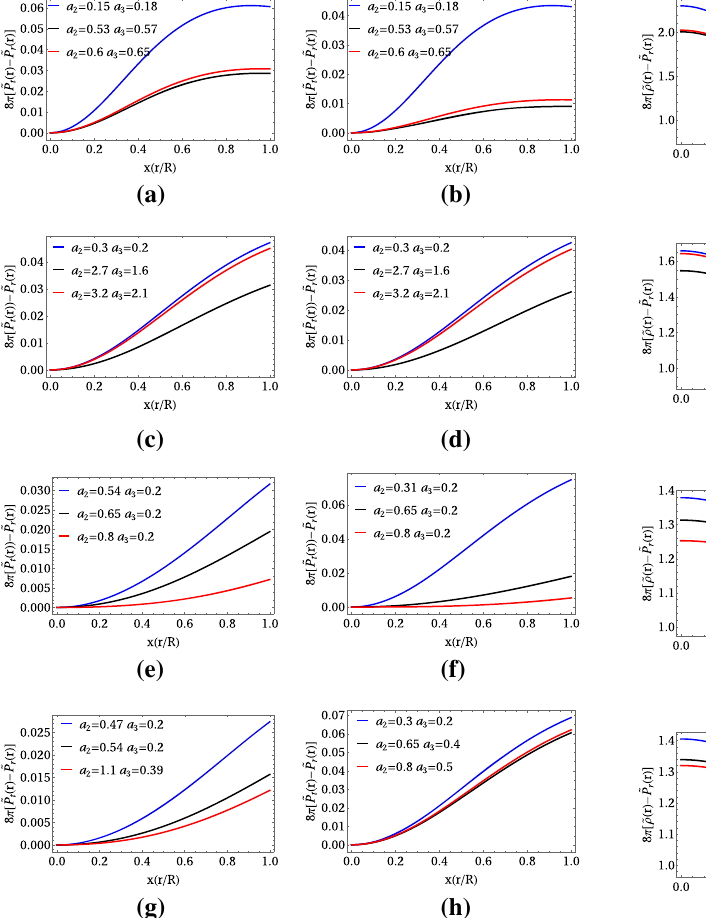
Fig. 6 ˜ P t ( r ) − ˜ P r ( r ) as a function of r for Model 1: ( a ) u = 0.19803, ( b ) u = 0.2035, Model 2: ( c ) u = 0.19803, ( d ) u = 0.2035, Model 3: ( e ) u = 0.19803, ( f ) u = 0.2035, Model 4: ( g ) u = 0.19803, ( h ) u = 0.2035